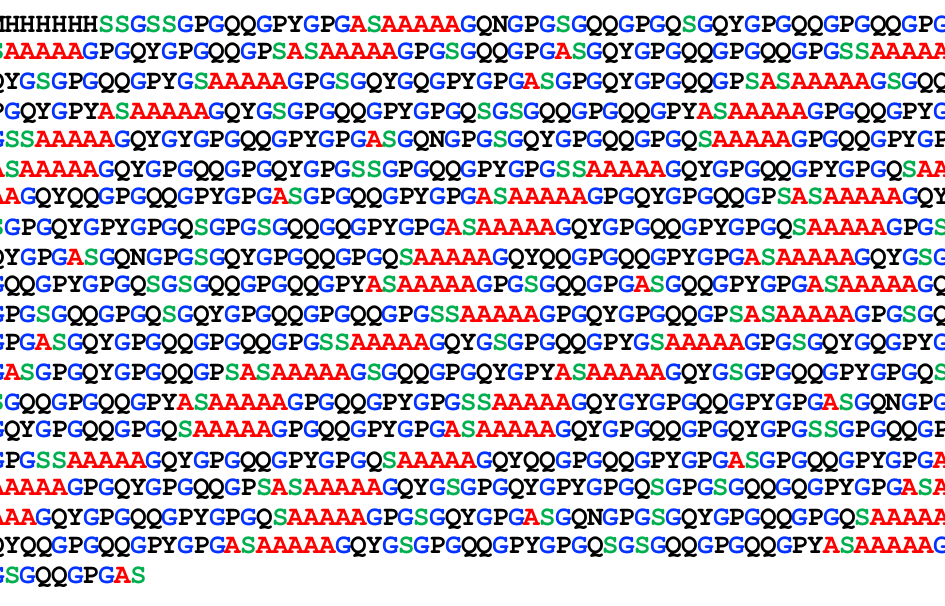
Figure 1. Amino acid sequence of BP1 using single-letter